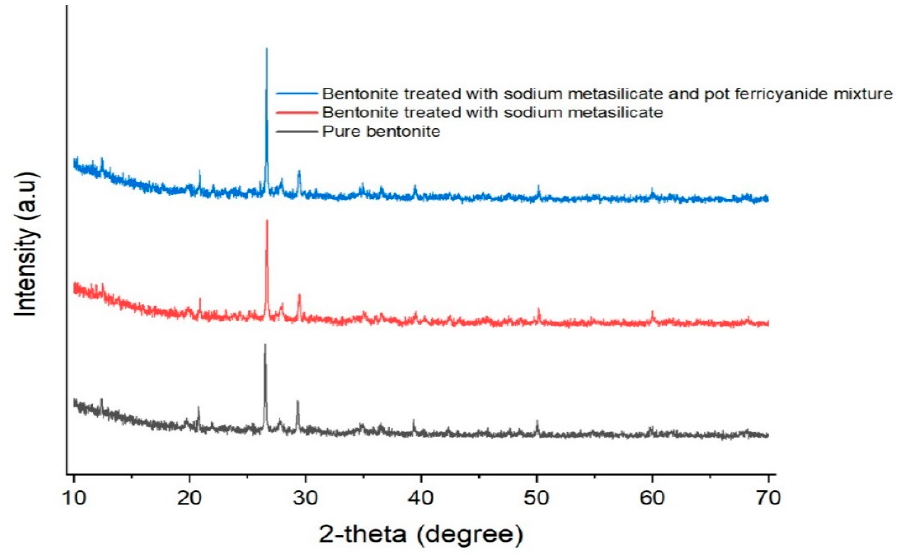
Figure 9. XRD analysis of bentonite nanocomposite, bentonite treated with sodium meta-silicate (BSM) nanocomposite, bentonite treated with sodium metasilicate and pot. ferricyanide nanocom- posite.